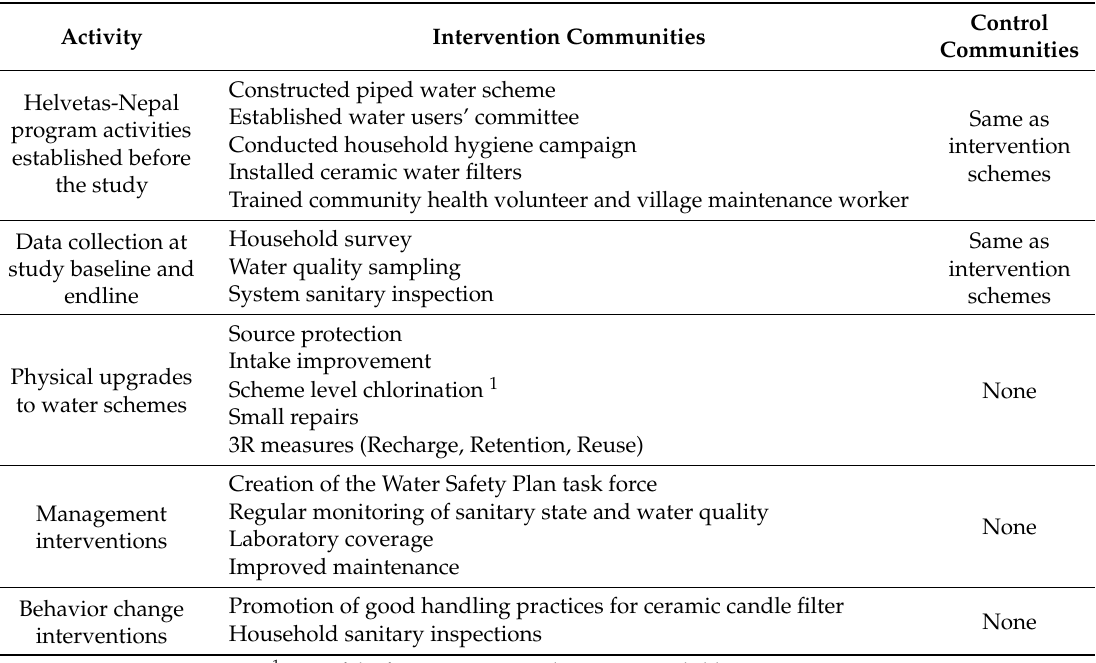
Figure 1. Map of Nepal with the district borders highlighting Dailekh district in blue and the intervention area, Dullu municipality, in orange. The map inset expands on the intervention area, showing the locations of the intervention and control schemes in relation to the field laboratories. Table 1. Activities carried out before and during the study period within intervention and control communities.